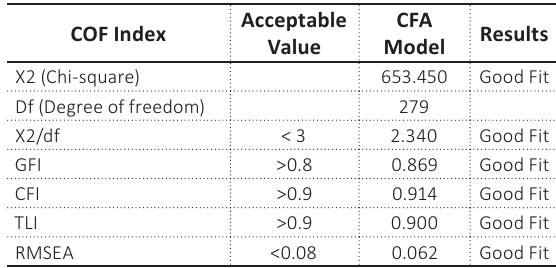
Table 4. Confirmatory factor analysis